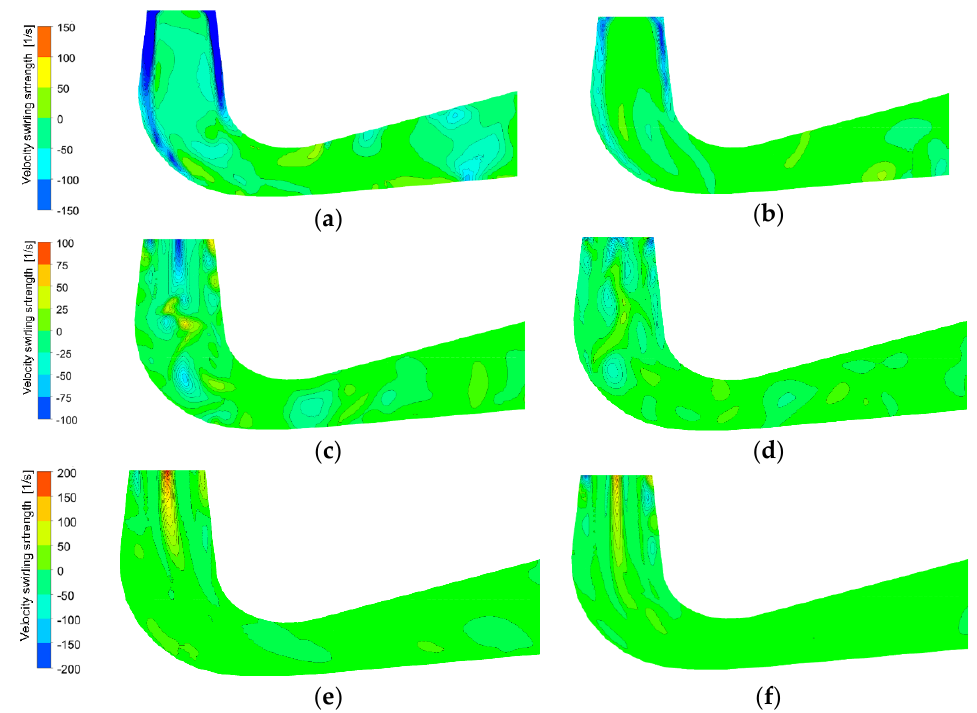
Figure 9. Vorticity distribution at the cross-section of the draft tube. ( a ) OP1, ( b ) OP2, ( c ) OP3, ( d ) OP4, ( e ) OP5, and ( f ) OP6. ( e ) OP5, and ( f )